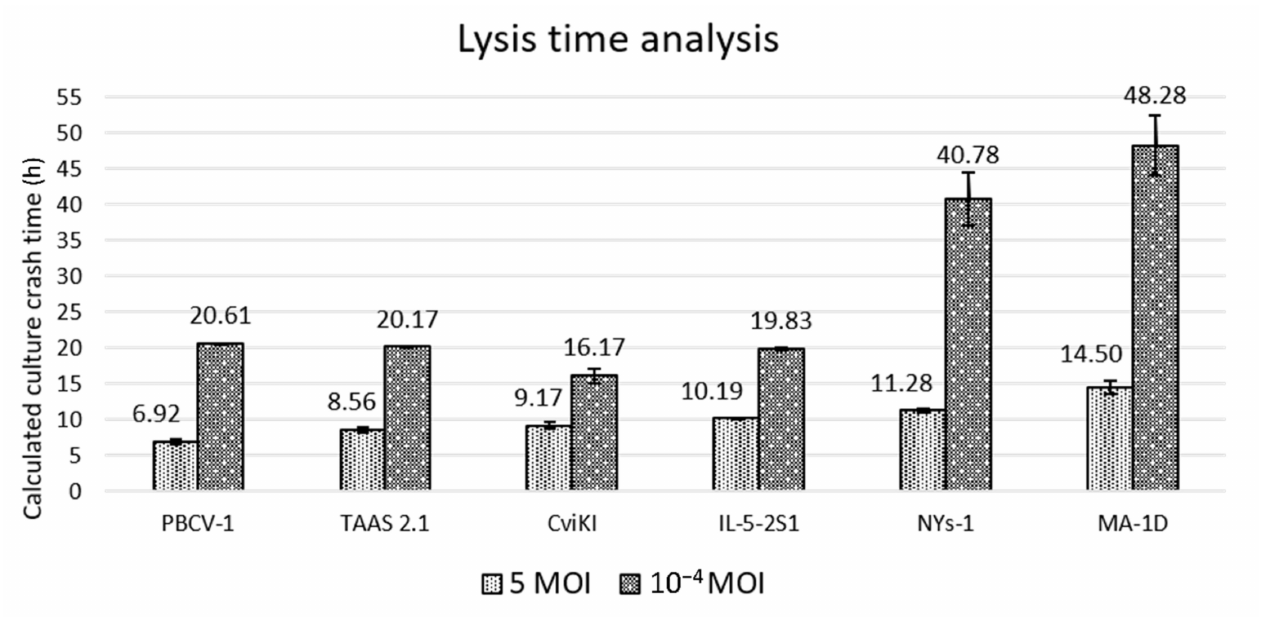
Figure 4. Calculated lysis time for PBCV-1, MA-1D, NYs-1, TAAS 2.1, CviKI, and IL-5-2S1 virus isolates. The data represent the average of 3 biological replicates with calculated standard